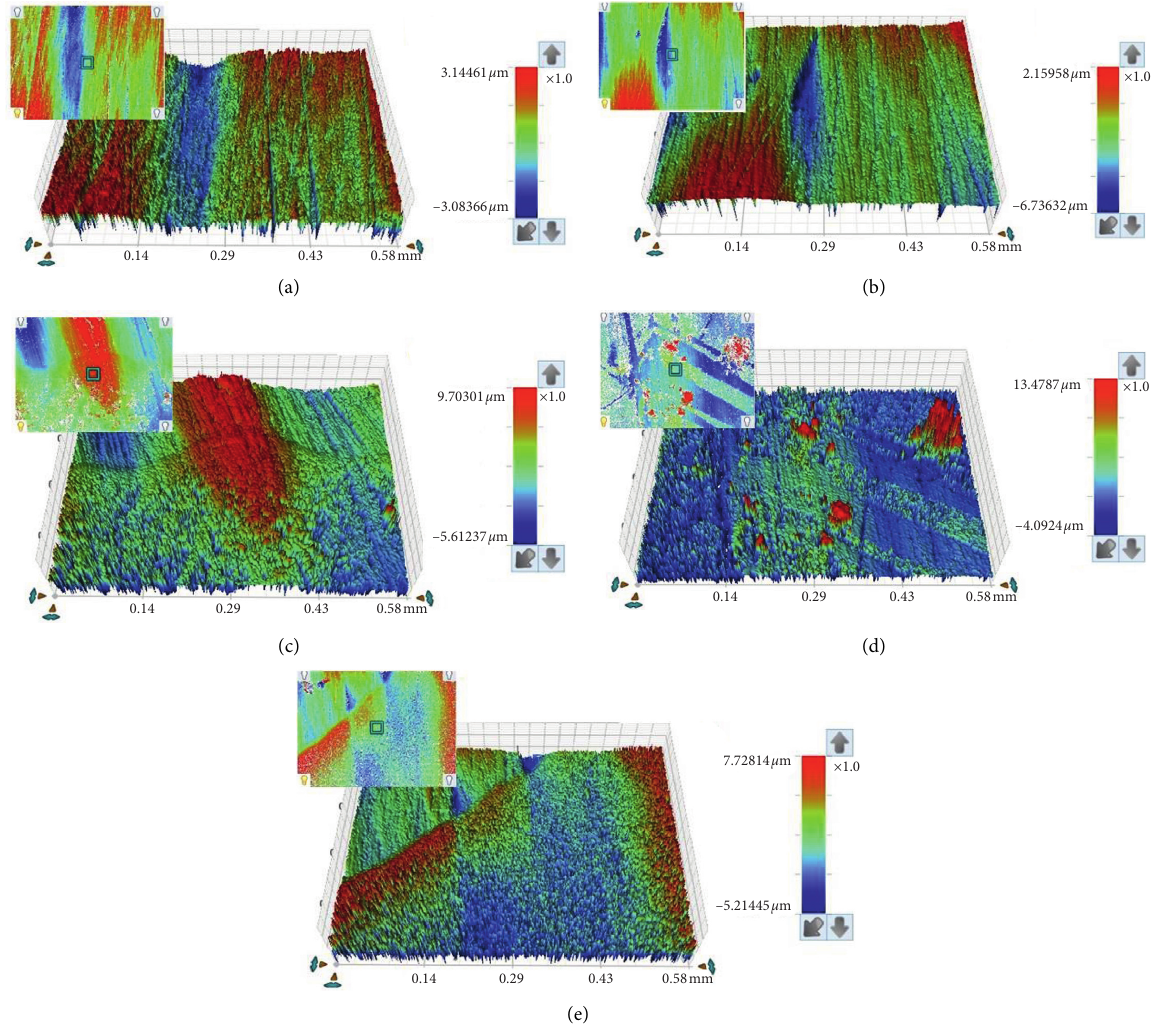
Figure 3: (a-e) Representative surfaces roughness images of unmodified specimens after immersion. (a) Baseline. (b) Distilled water. (c) Corega. (d) NaOCl. (e)